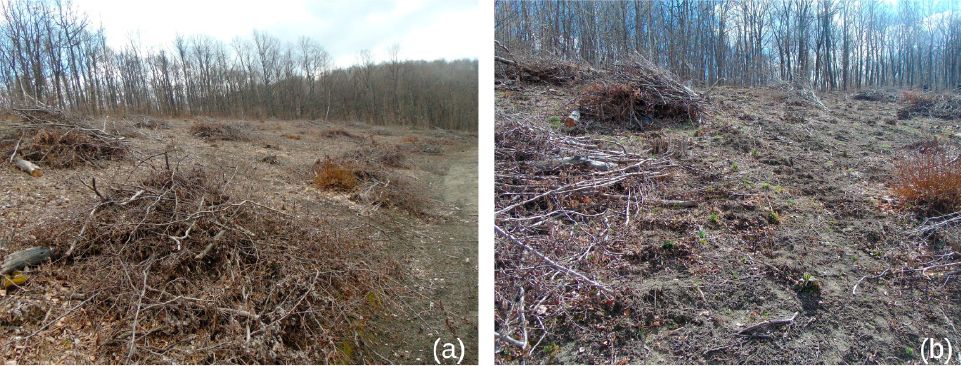
Figure 5. Degraded land change following afforestation: ( a )—degraded land; ( b )—afforested land.